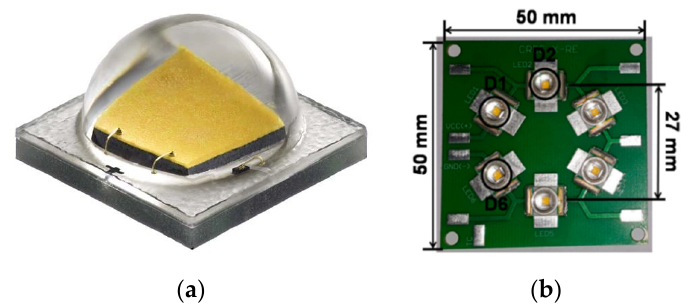
Figure 4. View of the XML2 power LED ( a ) and the LED Ring XRE module ( b ).